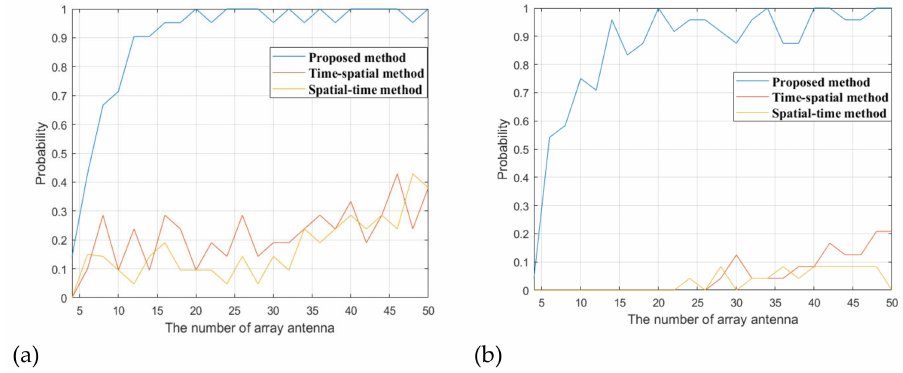
Figure 15. Comparison of interference suppression performance under different number of antenna arrays, ( a ) interference from the sidelobe, ( b ) interference from the main lobe.